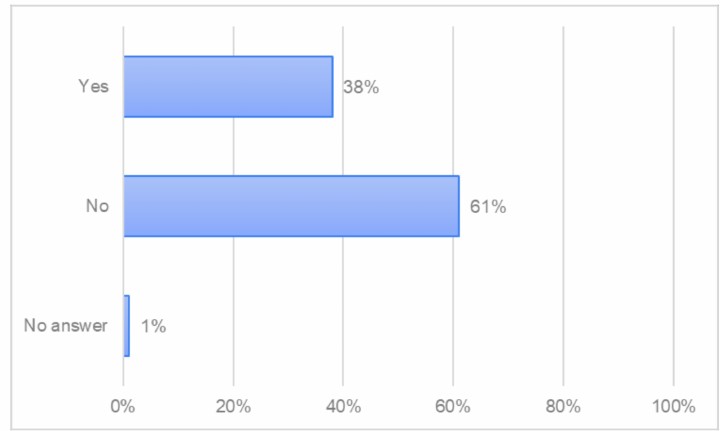
Figure 13. Summary of injuries to tree climbers caused by stinging